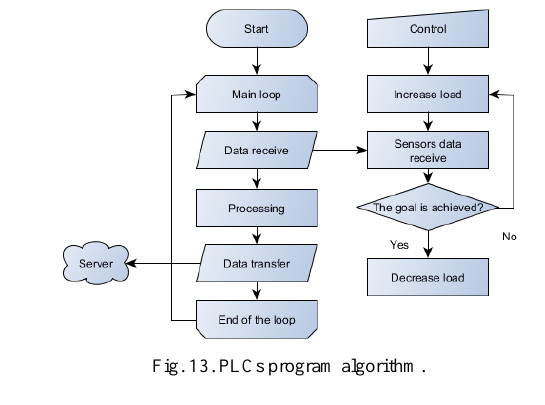
Fig. 12. Laboratory system for data acquisition and control.